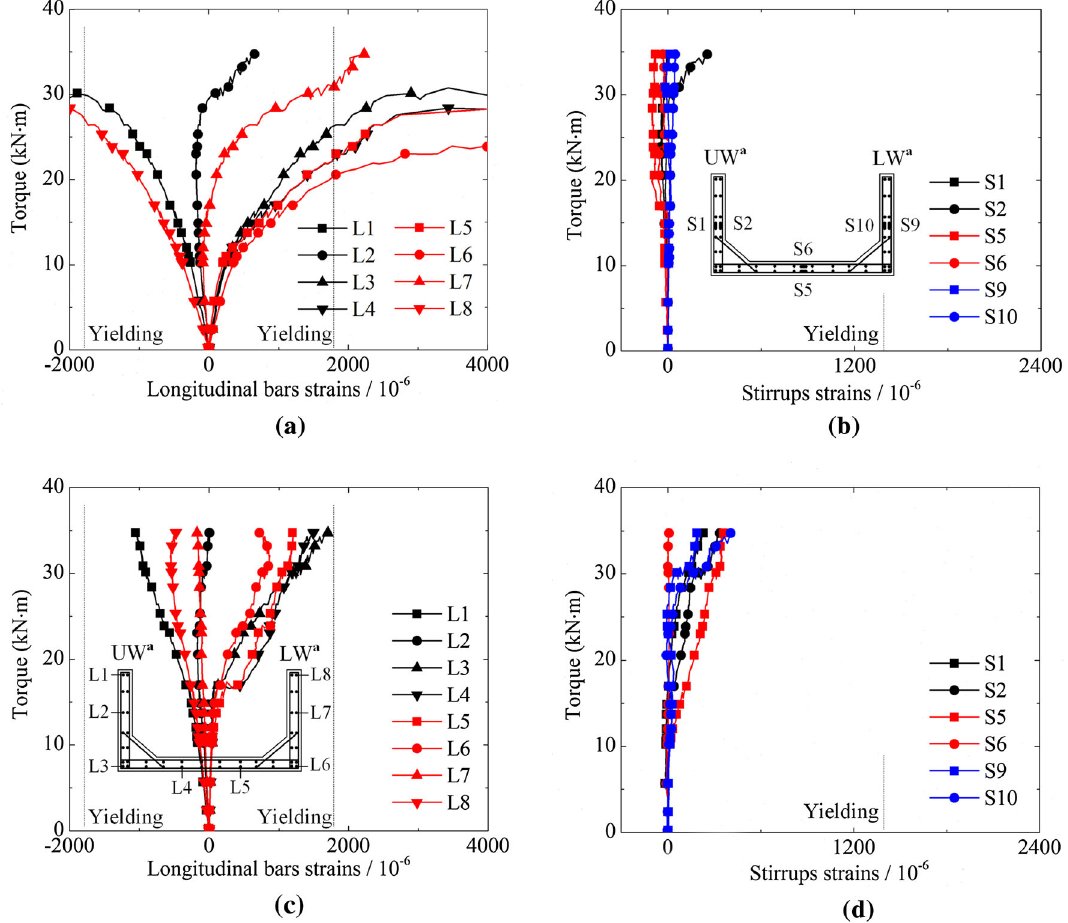
Fig. 9 Reinforcement strains of MEM-1:5. a Longitudinal bars strains at mid-span, b stirrup strains at mid-span, c longitudinal bars strains at quarter span, and d stirrup strains at quarter span. a The ‘‘LW’’ and ‘‘UW’’ mean ‘‘Loaded Web’’ and ‘‘Unloaded Web,’’